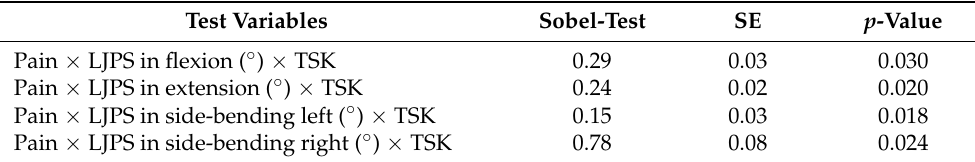
Table 4. Sobel test for indirect effect for statistical